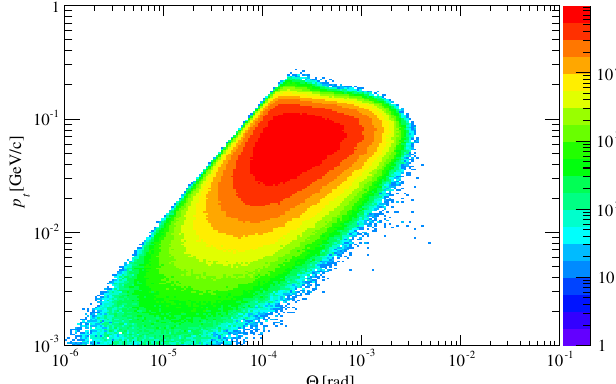
FIG. 2. Comparison between spectra of coherent pairs pro- duced by CAIN and GUINEA-PIG++. The sign of the energy corresponds to the sign of the charge.